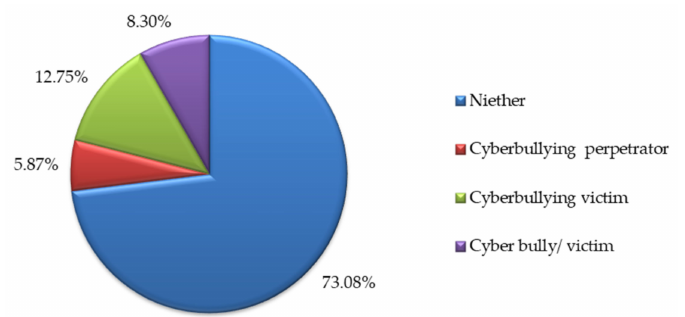
Figure 3. Participation in cyberbullying.